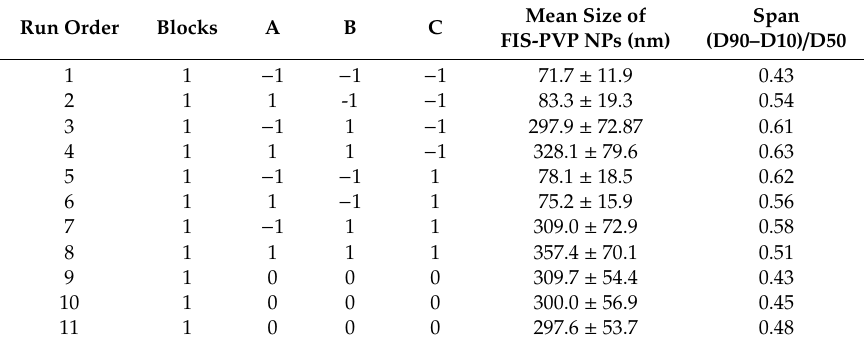
Table 3. Experimental results based on a Minitab full factorial